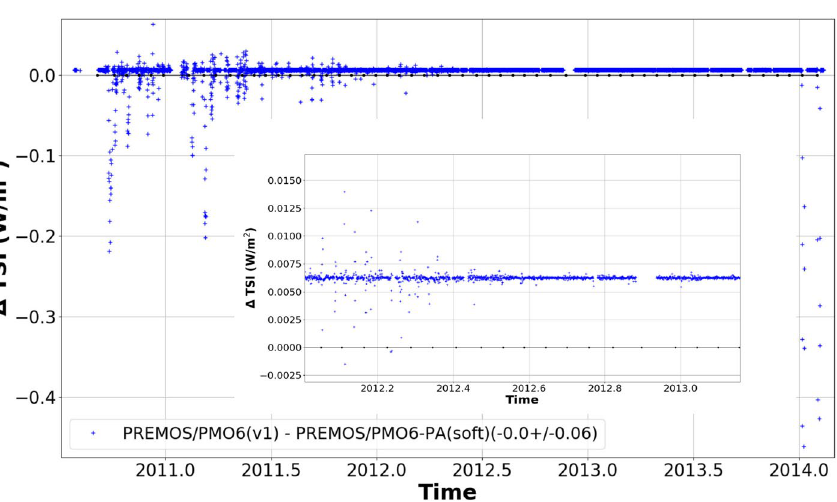
Figure 2. The difference between the TSI time series calculated by the machine-learning and data fusion algorithm and the manually determined solution by Ball et al. 22 (PREMOS/PMO6(v1)). The tiny offset 2 ( 0.0062Wm − ) between both solutions is well within the approximation uncertainties for both degradation curves. The occasional outliers are caused by different smoothing in both procedures. The zoom-in (insert) gives a better impression of the relative long-term stability between both solutions. There is no appreciable trend in our new solution compared to the original